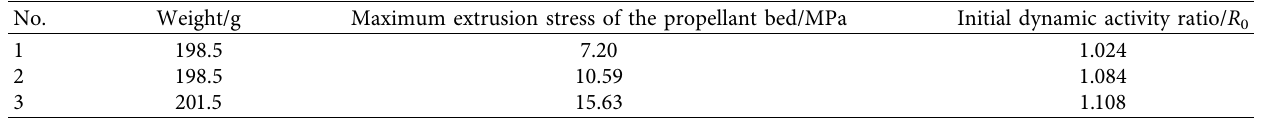
Figure 3: P-t curves, dynamic activity curves, and dynamic activity ratio curves of propellants. (a) P-t curves, (b) dynamic activity curves, and (c) dynamic activity ratio curves. Table 5: Test data of the initial dynamic activity ratio of samples without storage.